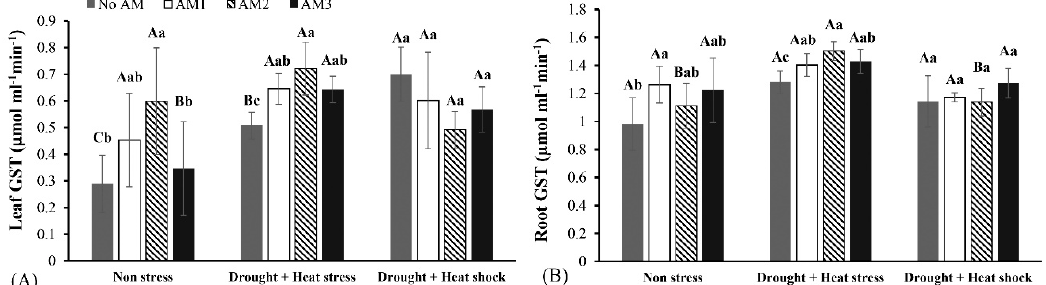
Figure 5. The activity of glutathione S transferase (GST) in leaves ( A ) and roots ( B ) of non-inoculated plants (No AM) and plants inoculated by R. irregularis (AM1), F. mosseae (AM2), or F. coronatum (AM3) subjected to non-stress (NoS), drought + heat stress (D + H), and drought+ heat shock (D + HS). Each bar represents the mean and standard deviation (n = 4). Different minuscules indicate significant differences among treatments under the same conditions (no stress, drought + heat stress, or drought + heat shock) by Duncan’s post hoc test at p ≤ 0.05. Different capital letters indicate significant differences of the same treatments (No AM, R. irregularis, F. mosseae, or F. coronatum ) under different conditions (no stress, drought + heat stress, and drought + heat shock) by Duncan’s post hoc test at p ≤ 0.05.